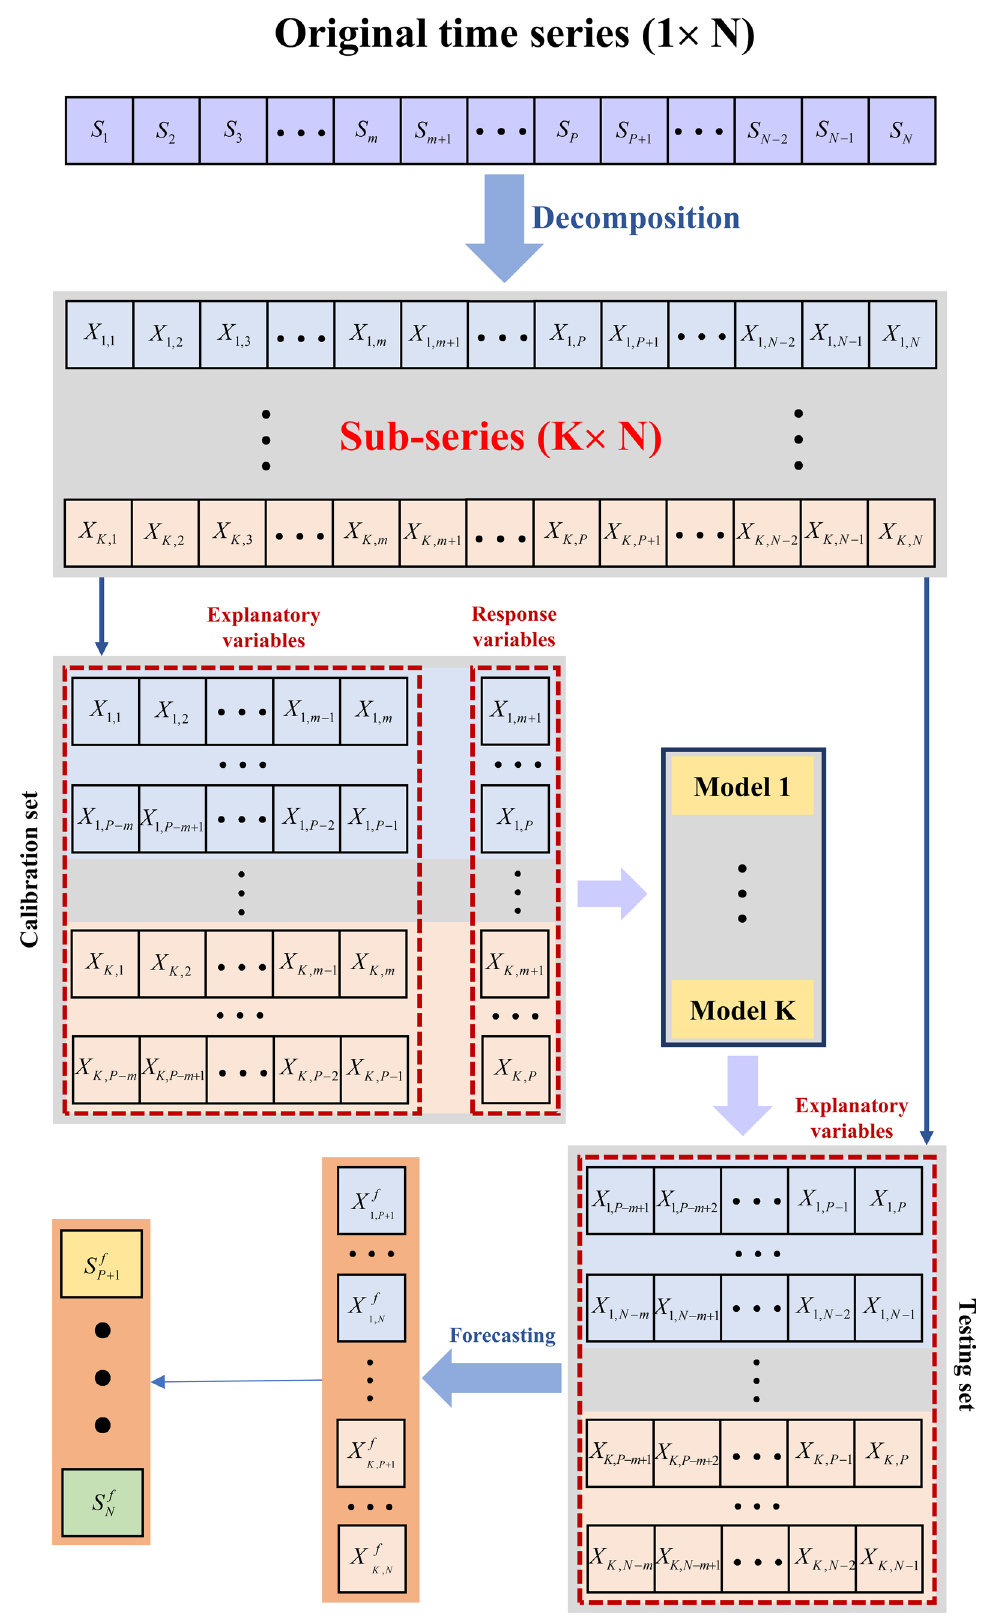
Fig. 1 The process of OD sampling